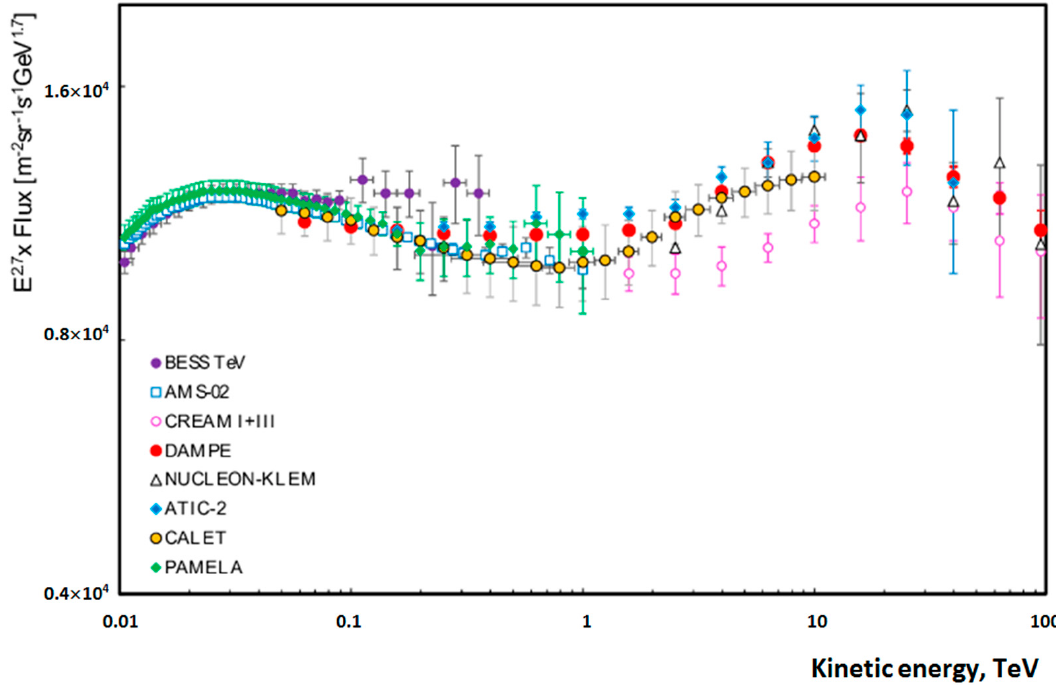
Figure 1. Proton spectra of various experiments [11–19].